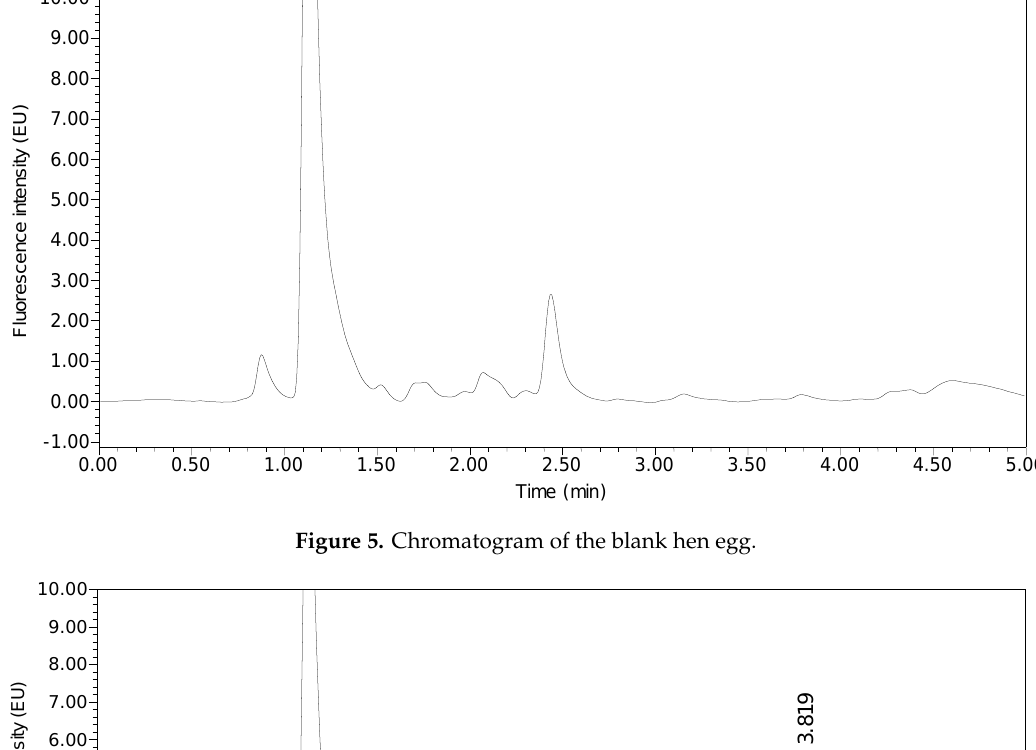
Figure 4. Chromatogram of the standards (25 µg/kg TAP and 50 µg/kg FF and FFA standards).